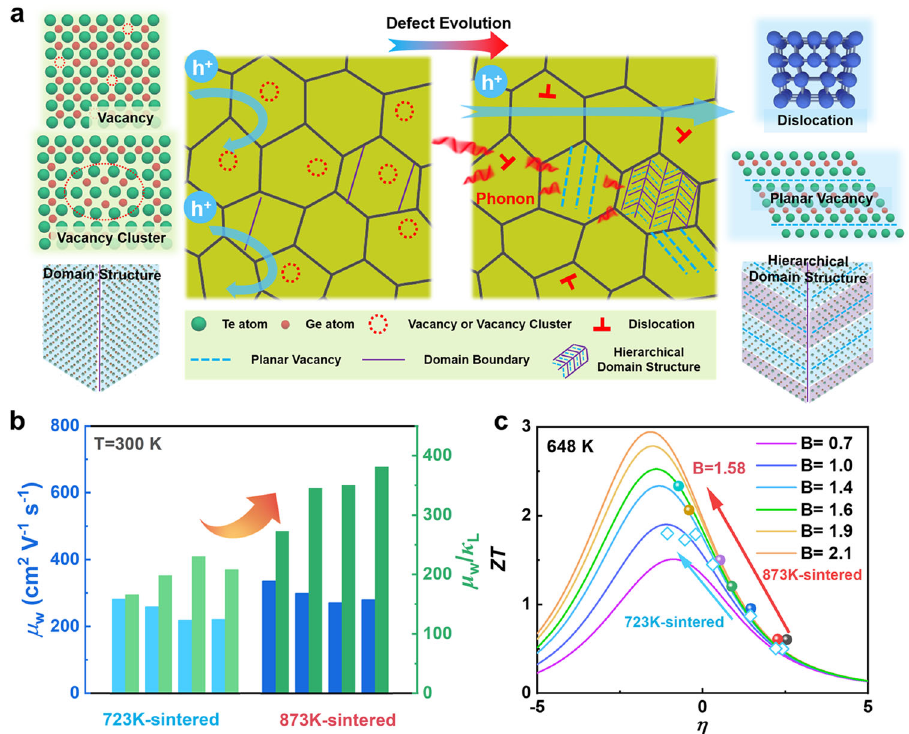
Fig. 1 | Synergistic control of the carrier and phonon transports via defect engineering. a The schematic diagram presenting the behaviors of carriers and phonons in the GeTe-based compounds with the presence of hierarchical struc- tures. b The weighted mobility μ w and the value of μ w / κ L of Ge-de fi cient samples